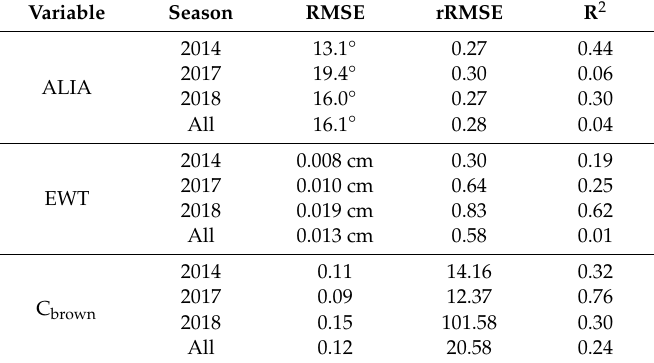
Table 6. Distance measures between in situ observations of ALIA, EWT and C brown vs. optimized values in the manual fitting process for silage